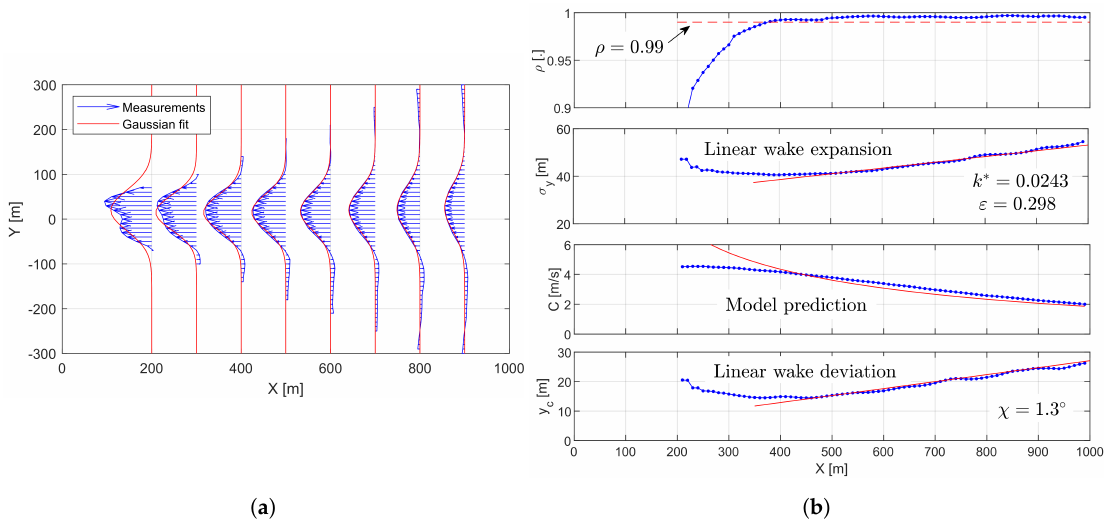
Figure 8. Example of the analysis of the wake of the wind turbine. ( a ) Velocity deficit and Gaussian fits; ( b ) Downstream evolution of the fit parameters. 22h30–23h00, 15 September